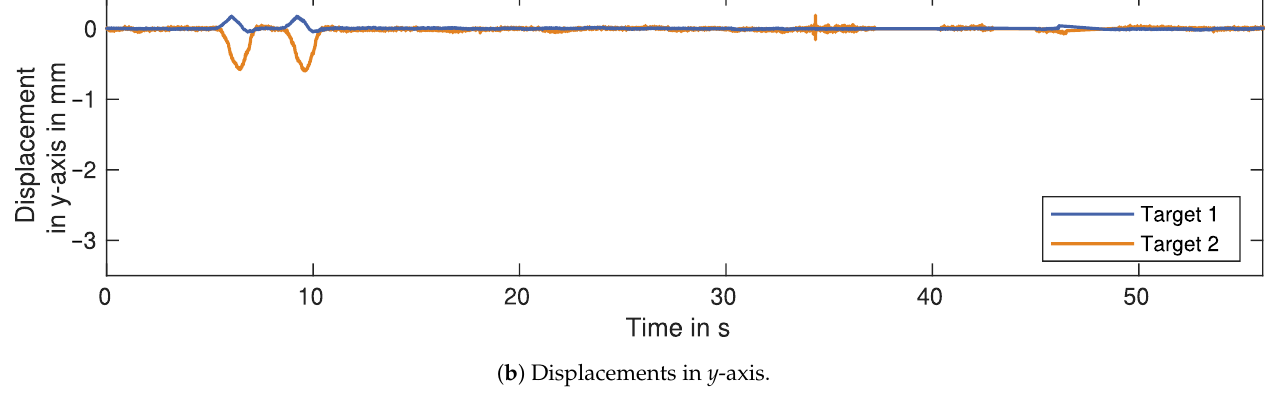
Table 2. Measurement uncertainty of the displacements for the two targets and GBRs. Target GBR LOS